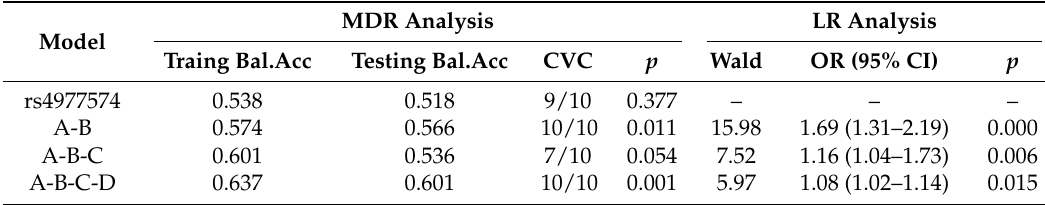
Table 5. Gene–gene interactions on the risk of CHD.